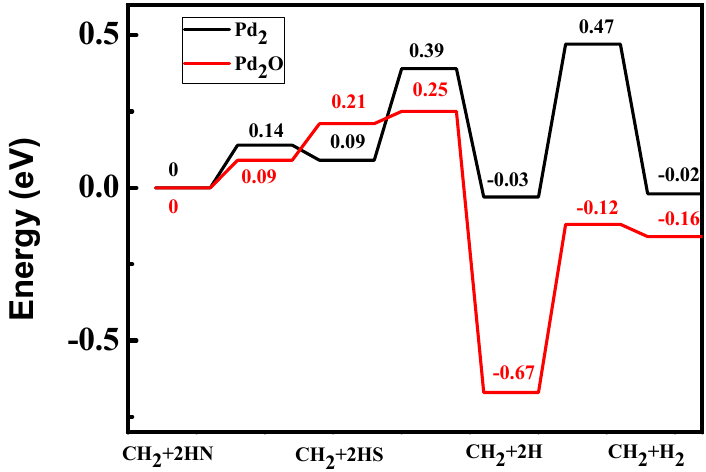
Figure 9. Energy profiles of hydrogen generation: CH 2 + 2H → CH 2 + H 2 on Pd 2 and Pd 2 O.